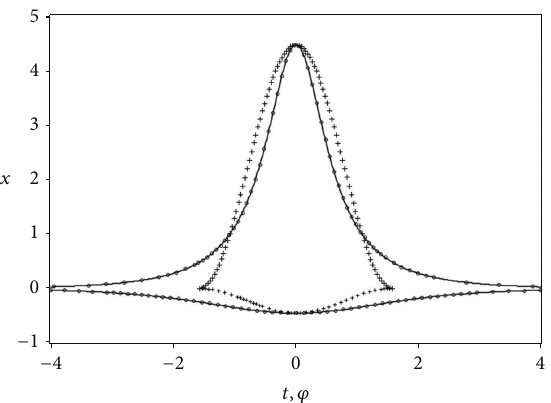
Figure 1: Time histories for homoclinic solutions of (23): — AUTO numericalmethod[30,31]; I I I presentmethod; +++ generalized harmonic function perturbation method [20].